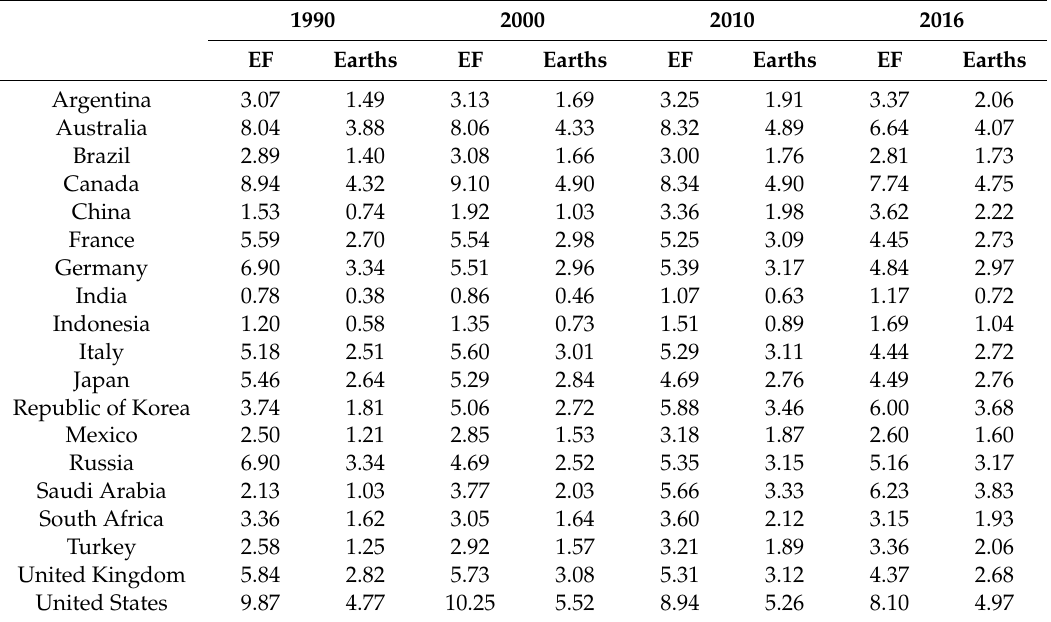
Table 1. Ecological footprint (EF) values and “number of Earths” of G20 countries for the time period